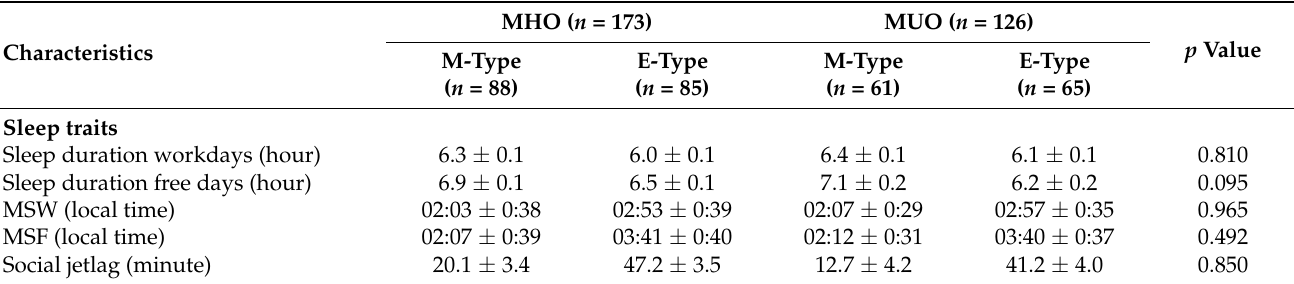
Table 3. Lifestyle characteristics and dietary intake according to metabolic health status and